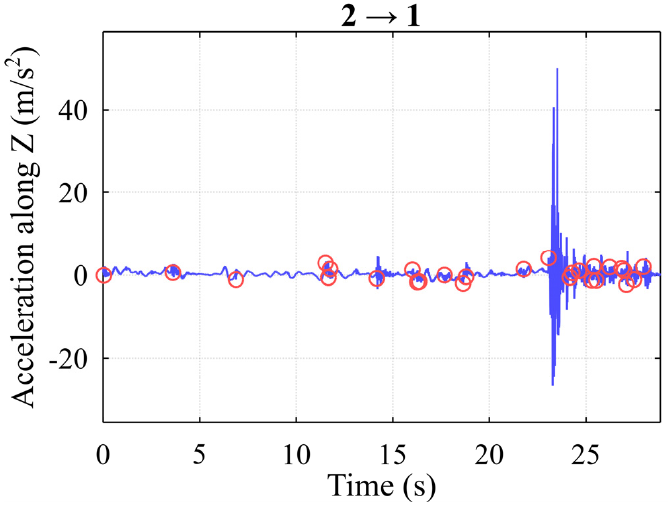
Figure 19. The result is from an incorrect selection of parameters (here the red circles indicate the registered events).